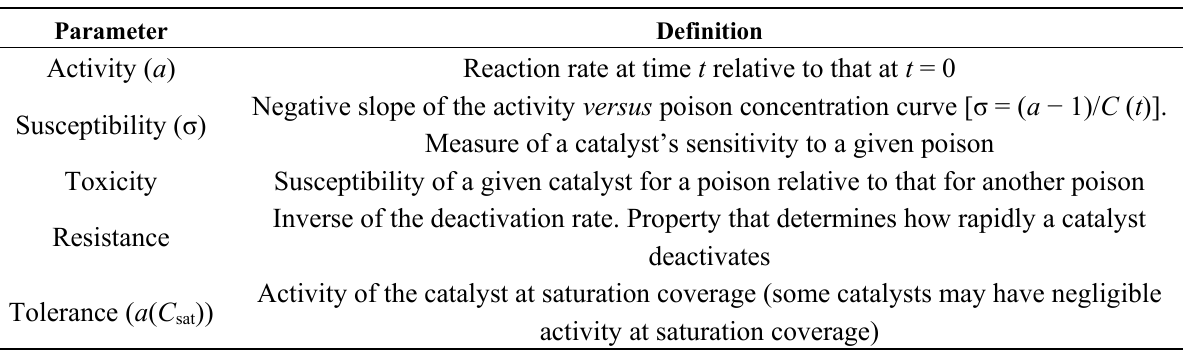
Figure 2. Three kinds of poisoning behavior in terms of normalized activity versus normalized poison concentration. Reproduced from [8]. Copyright 2006, Wiley-Interscience. Table 4. Important Poisoning